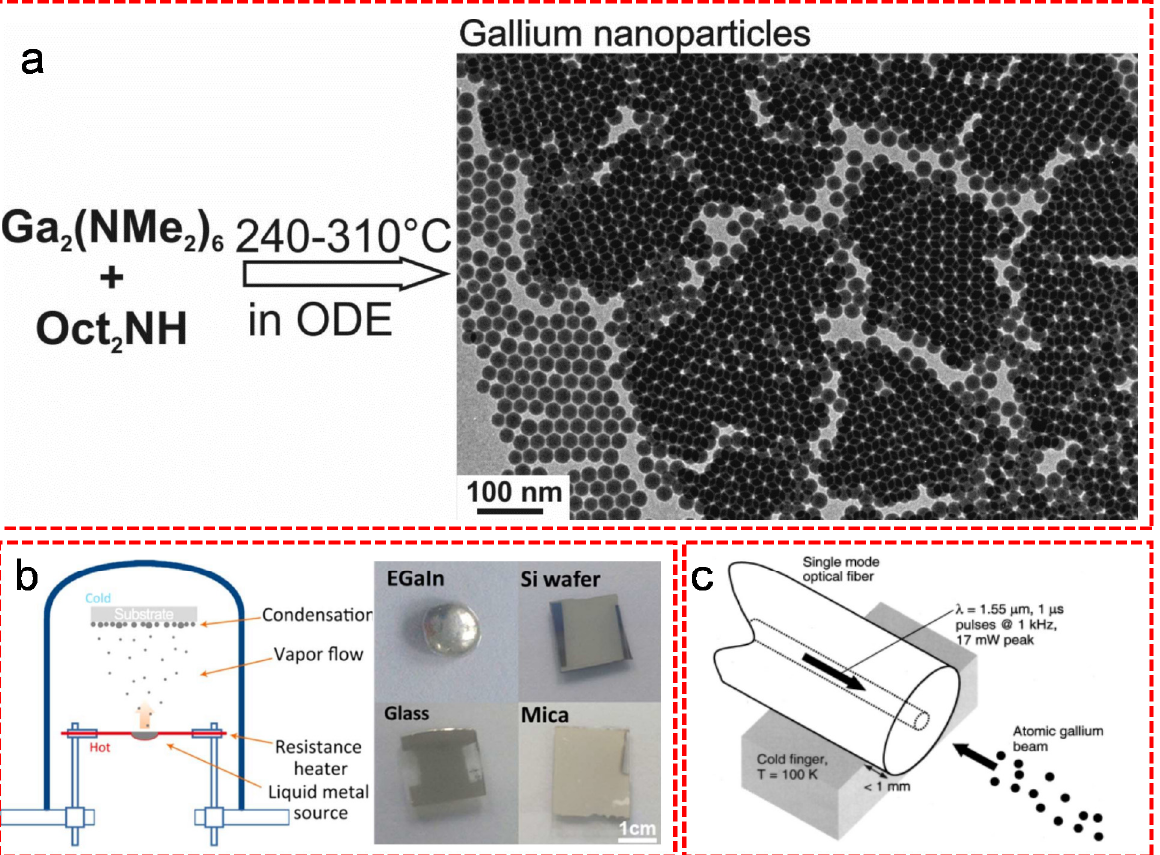
Figure 2. ( a ) The schematic of the synthesis of Ga nanoparticles via thermal decomposition of Ga-alkylamides. Reproduced with permission. [24] Copyright 2014, American Chemical Society. ( b ) The schematic for preparation of EGaIn nanoparticles on various substrates via physical vapor deposition. Reproduced with permission. [25] Copyright 2018, Elsevier B.V. ( c ) Sketch of the apparatus for preparation of gallium nanoparticles on the silica fiber from atomic gallium beam. Reproduced with permission. [26] Copyright 2002, American Institute of Physics.